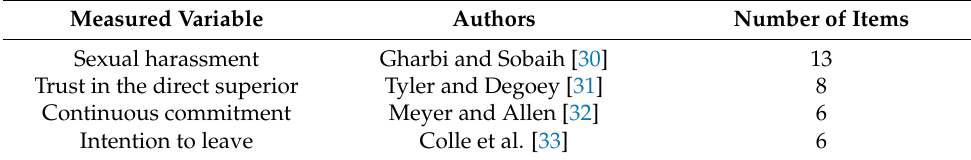
Table 1. The scales used in the research